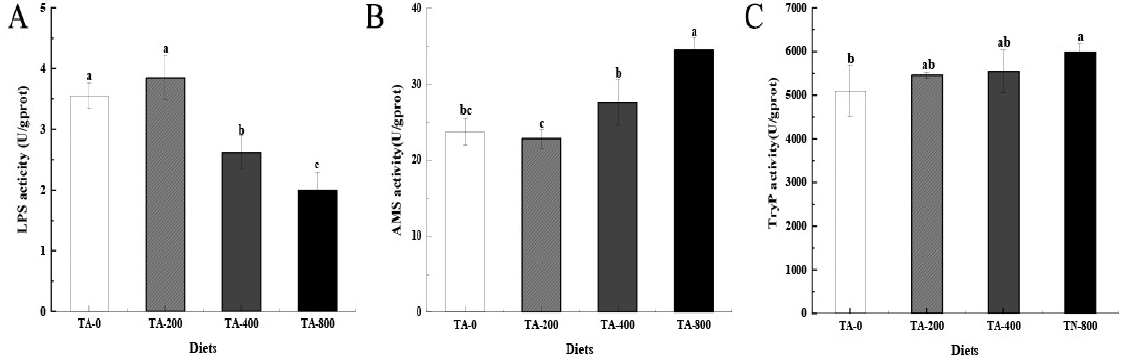
Figure 4. Effects of dietary TA on digestive enzyme activities in the intestines of L. vannamei. ( A ) LPS activity; ( B ) AMS activity; ( C ) Tryp activity. Vertical bars represented the mean values ± SD ( n = 3). Data marked with different letters were significantly different ( p < 0.05) among groups.